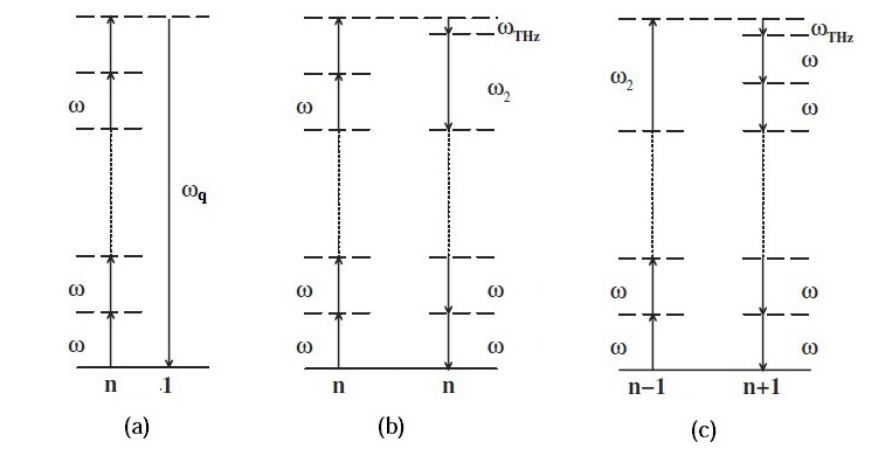
Figure 1. ( a ) The up-conversion of the fundamental frequency ( ω ) to generate the q th high harmonics ω q ; and ( b , c ) the general process of the down-conversion of laser frequency ( ω ) to generate THz wave ( ω THz ), with the help of the second harmonic pulse ( ω 2